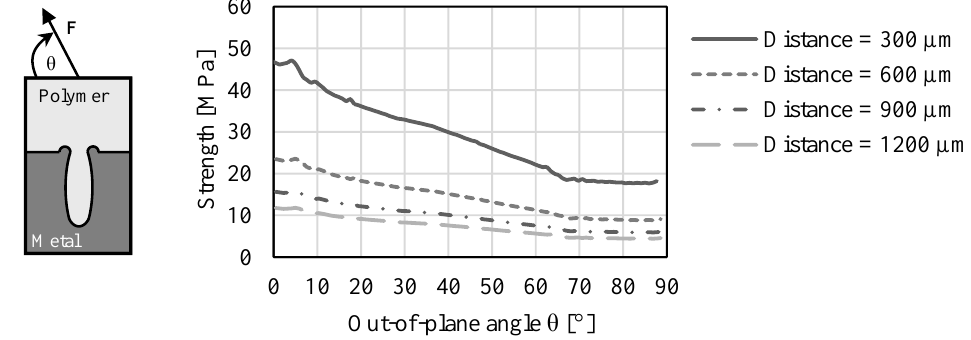
Figure 3. Mechanical characteristics of laser-based plastic–metal joints based on a FE-Model of a single cavity (RVE).